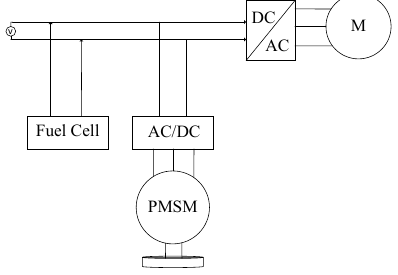
Fig. 12. Hybrid electric vehicle block diagram based on FESS .